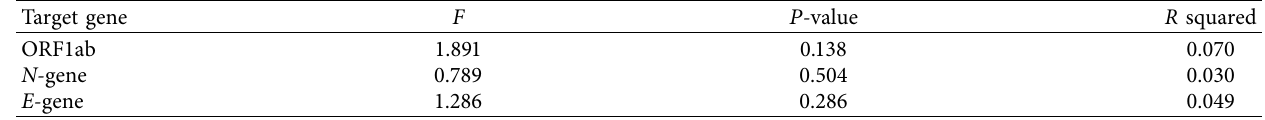
Table 3: One-way ANOVA